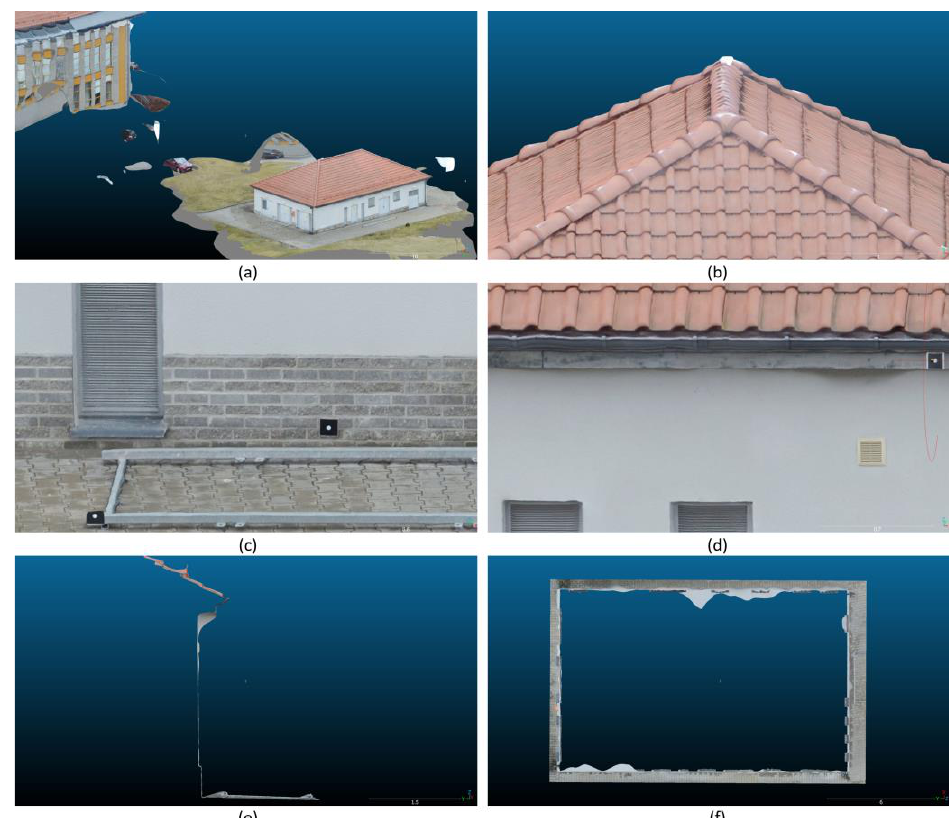
Figure 10. ContextCapture 3D mesh model: ( a ) general look on generated mesh 3D model; ( b ) roof geometry reconstruction; ( c ) façade with clinker tiles and wall without visible texture; ( d ) corners of the building roof and wall without visible texture; ( e ) vertical section of elevation 1; ( f ) top view on the building without a roof.